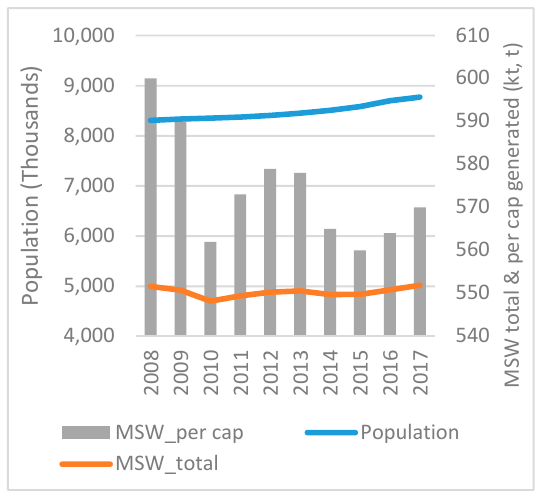
Figure 39. Population and MSW production in Austria 2008–2017 (EUROSTAT 2019a, 2019c).